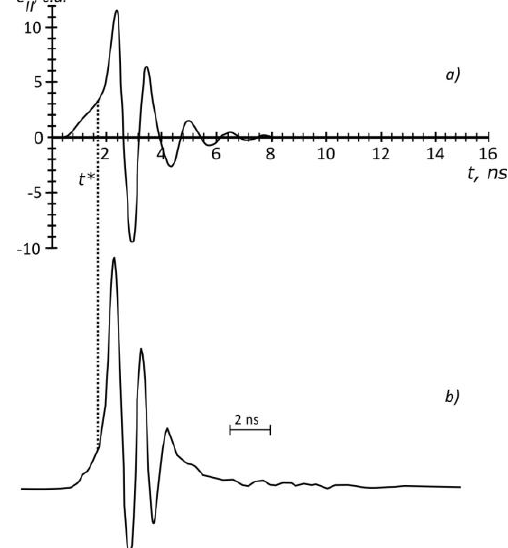
Fig. 2. Longitudinal calculated ( a ) and experimental ( b ) magnetization reversal signals obtained for the H p field pulse with rise time of 1.5 ns and the value of 30 Oe.